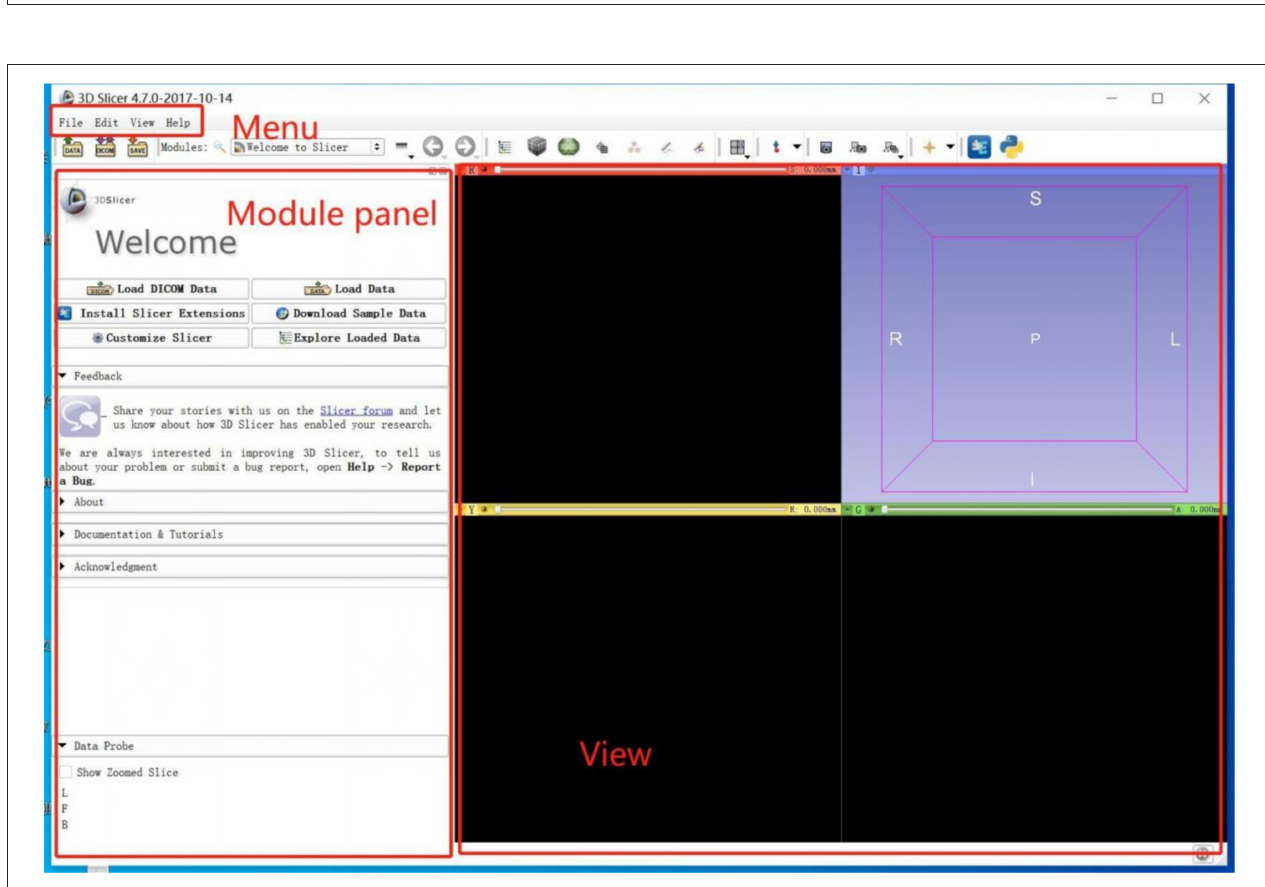
FIGURE 1 | A total of 327 patients with intracerebral aneurysms between February 2017 and August 2020 were collected. After selection, 130 aSAH patients were included. aSAH; aneurysms subarachnoid hemorrhage.